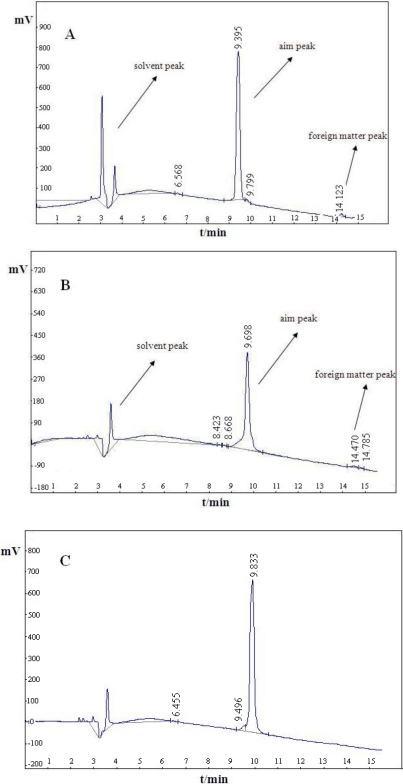
RP-HPLC analysis of PEGylated HM-3. Analysis was performed on a C18 column with water/ACN/TFA as eluent and a flow rate of 1 mL/min, and peaks were monitored at 220 nm. (A) ALD-mPEG5k-HM-3 purity: 97.39%, T: 9.395 min; (B) ALD-mPEG10k-HM-3 purity: 98.23%, T: 9.698 min; (C) SC-mPEG10k-HM-3 purity: 97.02%, T: 9.883 min; (D) SC-mPEG20k-HM-3 purity: 98.52%, T: 9.578 min.